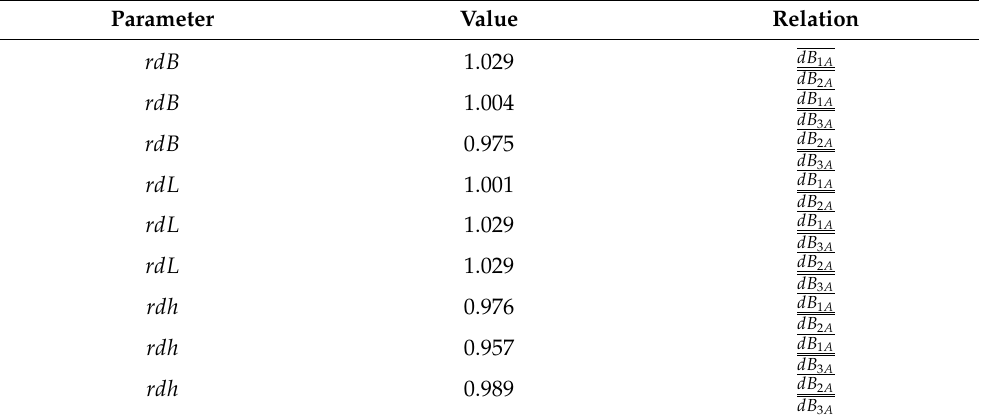
Table 4. The results of parameters ( rdB , rdL , rdh ) in flight test in D˛eblin.